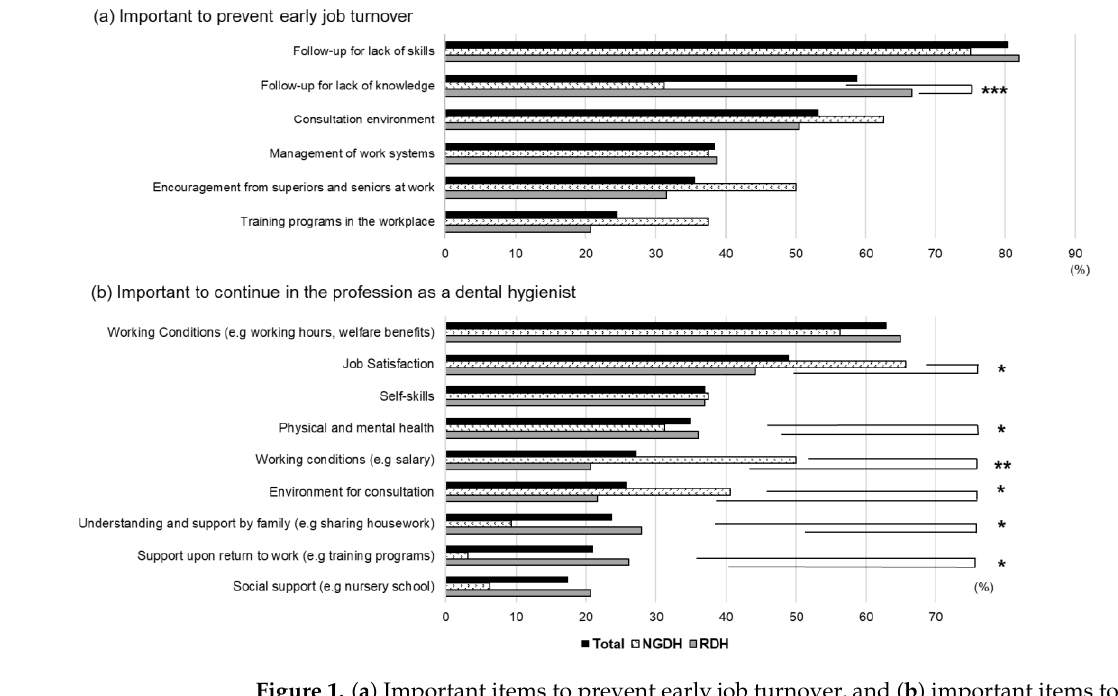
Figure 1. ( a ) Important items to prevent early job turnover, and ( b ) important items to continue in the profession as a dental hygienist. NGDH: new graduate dental hygienists, RDH: reinstated dental hygienists. * p < 0.05, ** p < 0.01, *** p < 0.001.